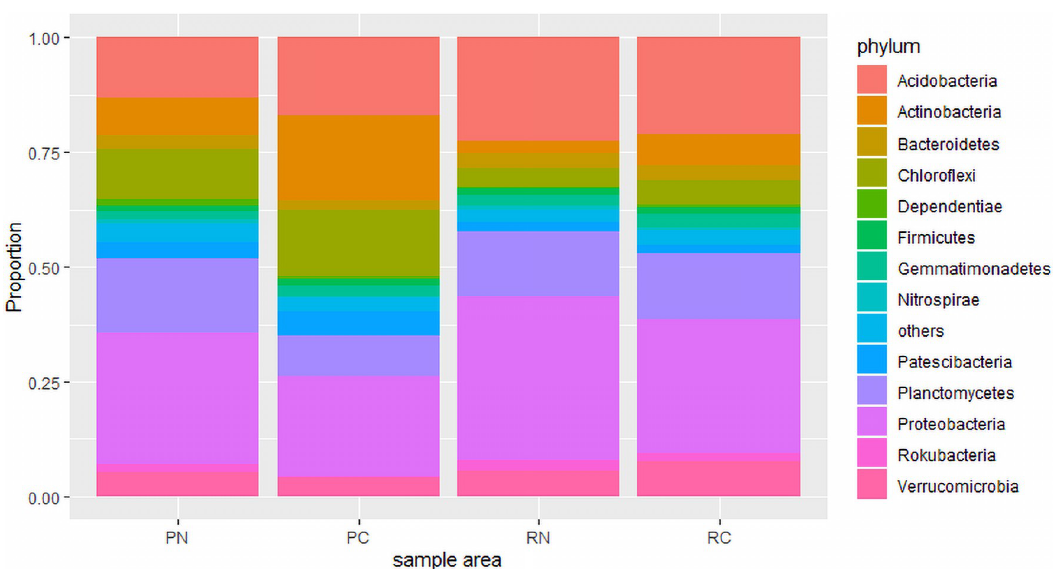
Fig 1. Relative abundance (%) of the dominant bacteria at the phylum level. PN, Nantou polluted area; PC, Changhua polluted area; RN, Nantou remediated area; RC, Changhua remediated area. The taxa of low abundance are pooled as “others”. https://doi.org/10.1371/journal.pone.0255137.g001 those of Ellin6067 (0.7% in PC, 2.0% in RC), Noviherbaspirillum (0.1% in PC, 1.6% in RC) and Ramlibacter (0.1% in PC, 2.9% in RC) were higher in RC and significantly different from those in PC (P < 0.05). In Nantou, the relative abundance of OTUs of Haliangium (4.0% in PN, 1.6% in RN) was higher in PN and significantly different from those in RN (P < 0.05), and those of Lysobacter (0.2% in PN, 1.3% in RN) and Ramlibacter (0.4% in PN, 1.7% in RN) was higher in RN and significantly different from those in PN (P < 0.05).